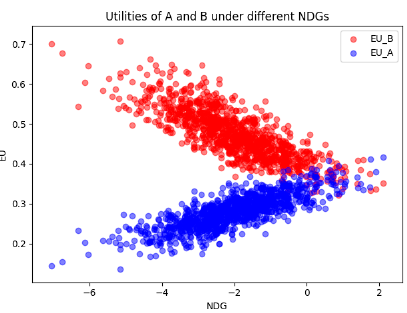
Figure 6. The relationship between the NDG and the expected utility of each